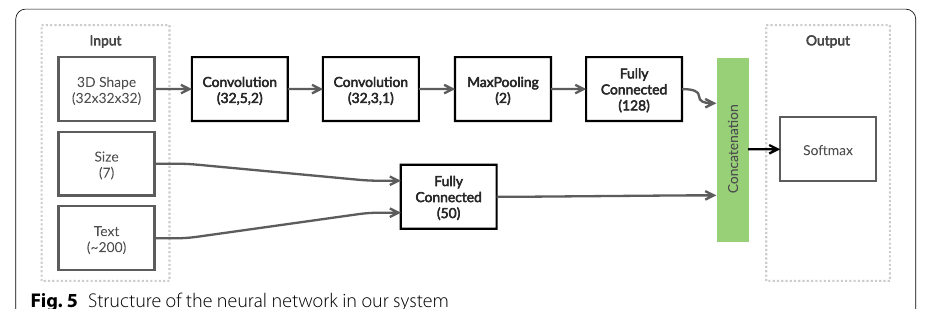
Fig. 5 Structure of the neural network in our